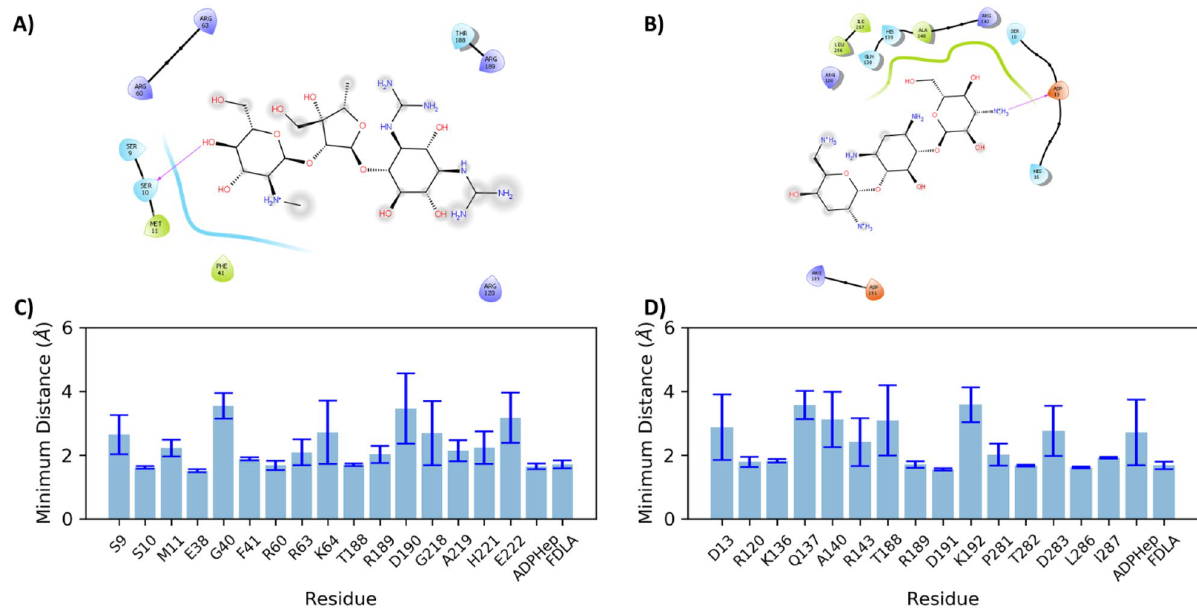
Figure 7. ( A ) Streptomycin Ligand Interaction Diagram ( B ) Tobramycin Ligand Interaction Diagram ( C ) Residues with minimum distance < 3.5 Å from Streptomycin and ( D ) Residues with minimum distance < 3.5 Å from